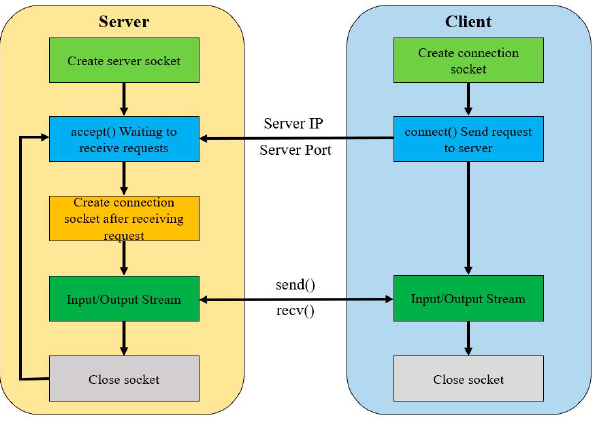
Figure 9. Socket communication model.